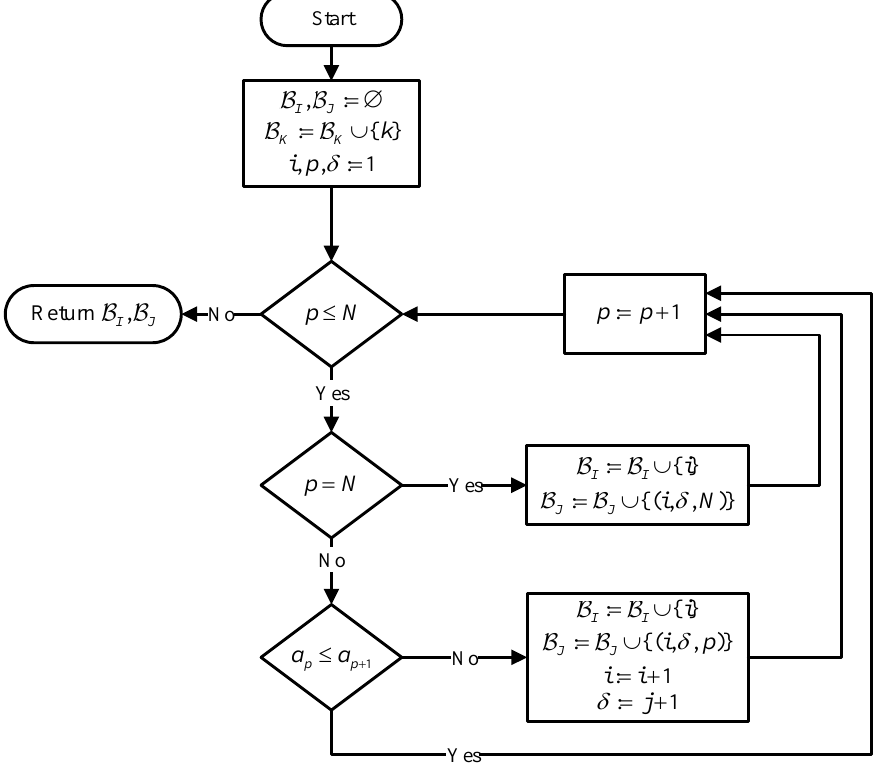
Figure A10. Flowchart for Algorithm